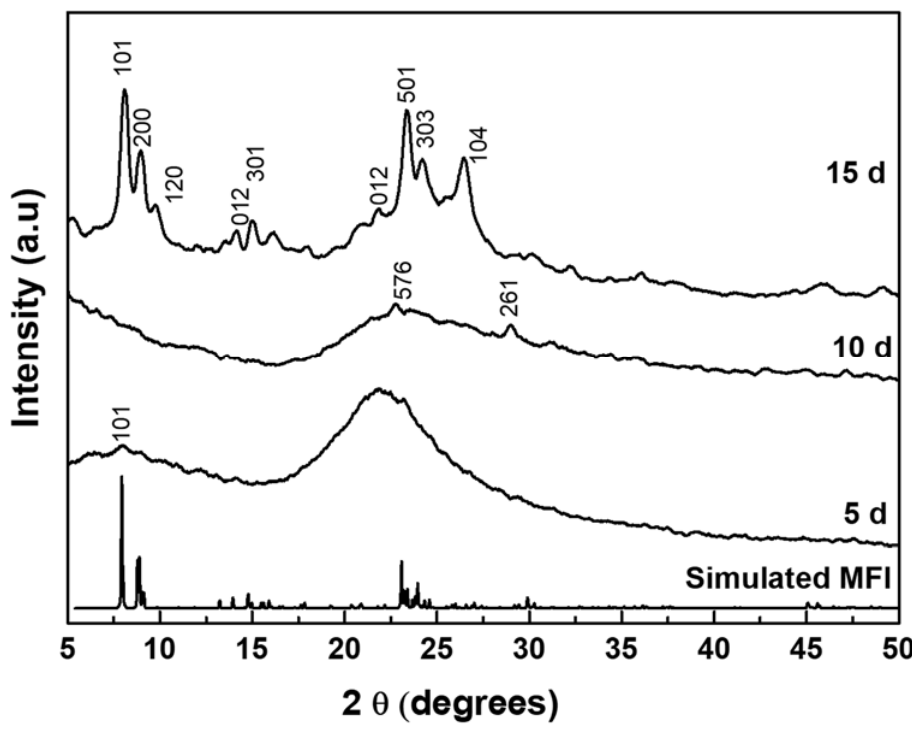
Figure 1. XRD diffraction patterns of powder samples synthesized at various hydrothermal times.